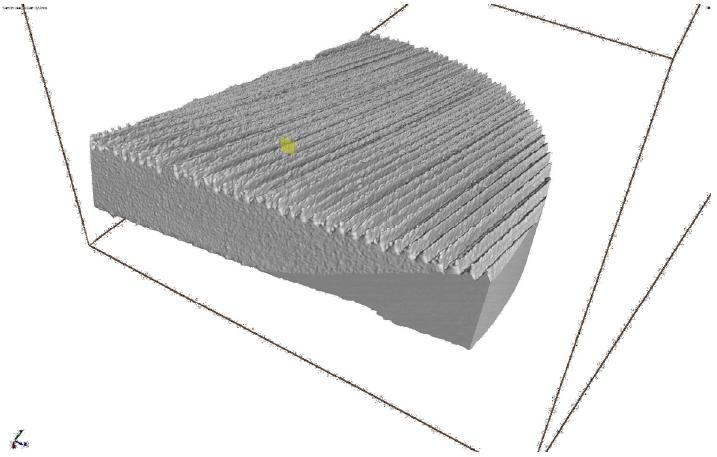
Figure 6. Visualization of the measurement results using CT for the selected sample.